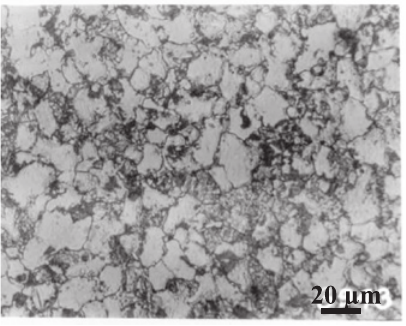
Fig. 9: Microstructure adjacent to rupture zone showing tiny micro-voids at the grain boundaries.